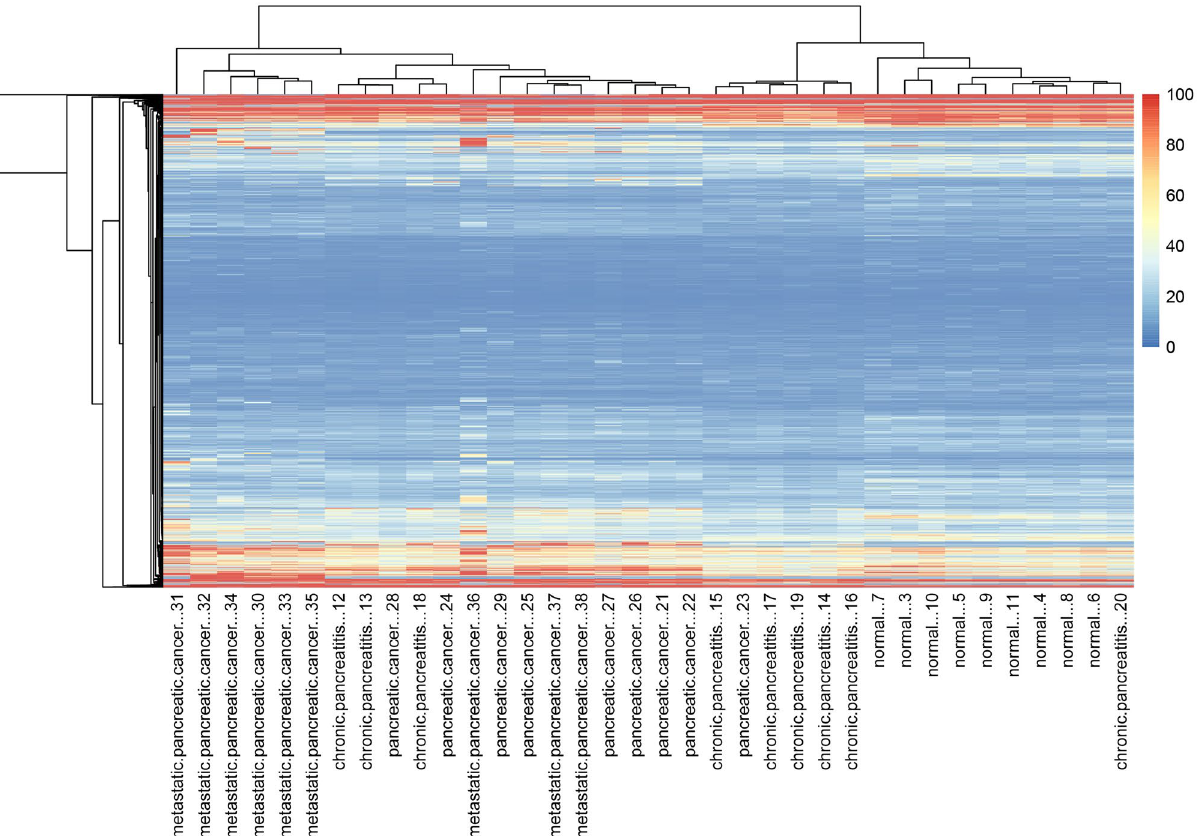
Figure 1. The cluster of all the genes in 36 samples including normal state, chronic pancreatitis, pancreatic cancer, and metastatic pancreatic cancer, each with nine